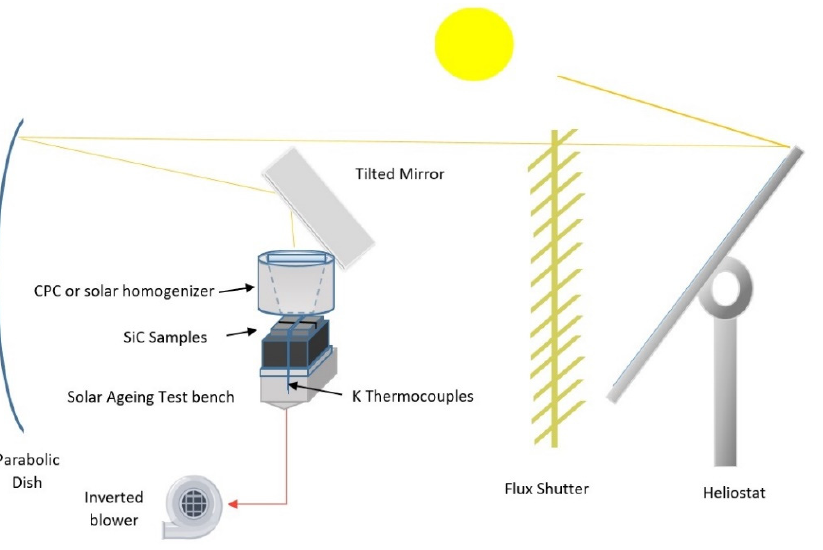
Figure 1. Schematic diagram of the solar ageing test bench in a horizontal solar furnace facility. This setup was used to carry out 500 ageing cycles at different periods, as described in Table 2, that were designed to cycle the inner temperature over a range from 300 up to 800 ◦ C or 1000 ◦ C, in order to compare the results with different temperatures and cycle periods. The cycle period (min/cycle) is the time needed to carry out a complete solar ageing cycle, including heating and cooling rate (Table 2). The maximum surface temperature (Tmax) and the flux (normalized at 1000 W/m 2 isolation) are